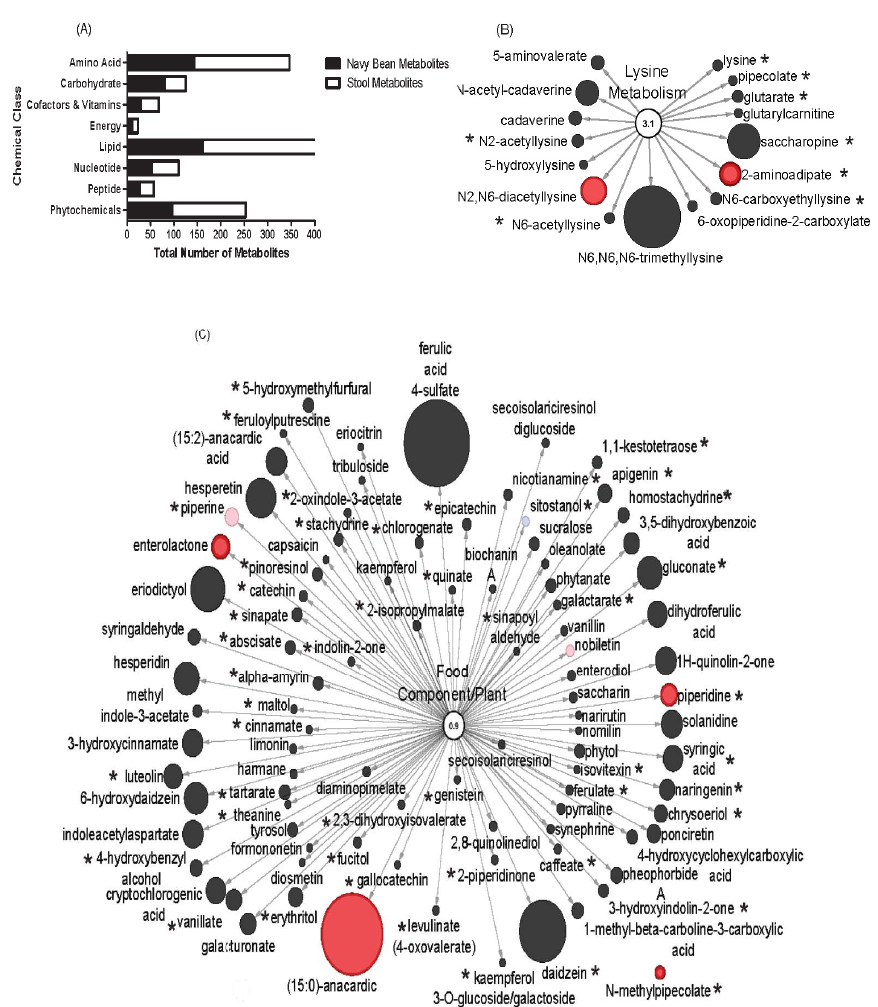
Figure 4. Overlap between navy bean (food) metabolome and stool metabolome of navy Figure 4 . Overlap between navy bean (food) metabolome and stool metabolome of navy bean consumers. (A) The stool metabolome contained 782 components and the overlap of metabolites from the cooked navy bean food (367 metabolites). Pathways of (B) lysine metabolism (16 metabolites) and (C) food and plant components (96 metabolites). Stool metabolites with black were not significant in the navy bean group over baseline. Red nodes indicate significant increase after consuming navy beans when compared to the baseline. The size of the circle relates to the relative abundance when scaled to all stool metabolites. The * indicates presence in the navy beans.